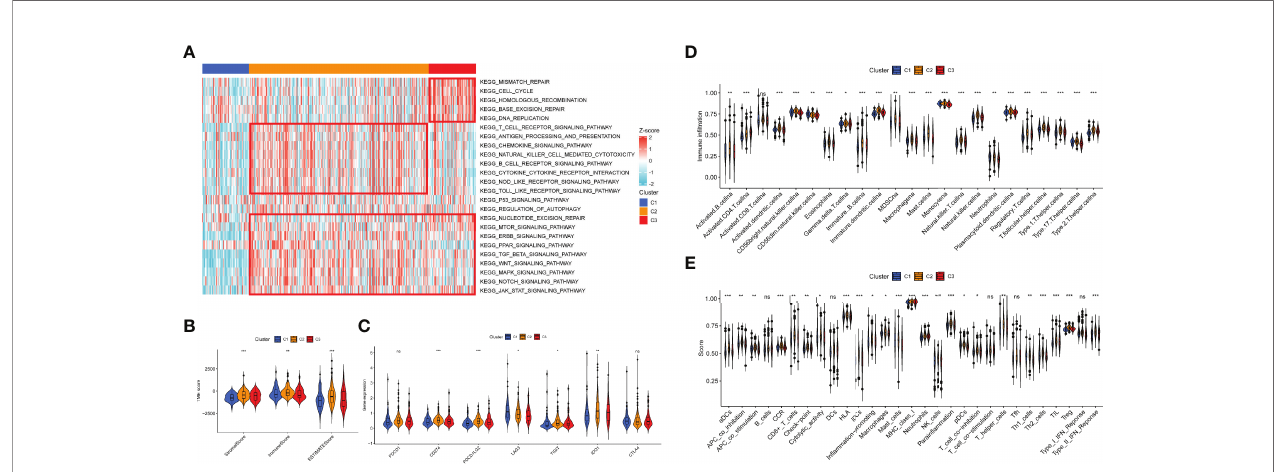
FIGURE 13 | Association between the TIME and m7G-related patterns. (A) The GSEA result in DNA damage repair, immune activation, and carcinogenic biological functions. (B) The ESTIMATE result of the three m7G phenotypes. (C) The expression of immune checkpoints in the m7G patterns. (D, E) Enrichment indices of TIICs (D) and immune functions (E) in the m7G patterns. TIME, tumor immune microenvironment; m7G, 7-methylguanosine; GSEA, gene set enrichment analysis; TIICs, tumor-in fi ltrating immune cells. *p < 0.05; **p < 0.01; ***p < 0.001, ns, no signi fi